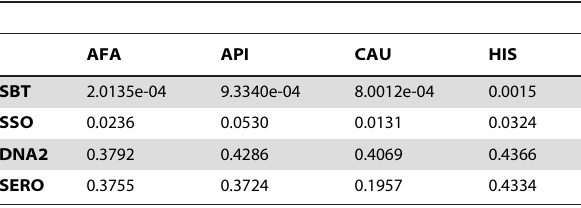
Table 6. Confirmatory typing (CT) mismatch rates for all typing methods and all population